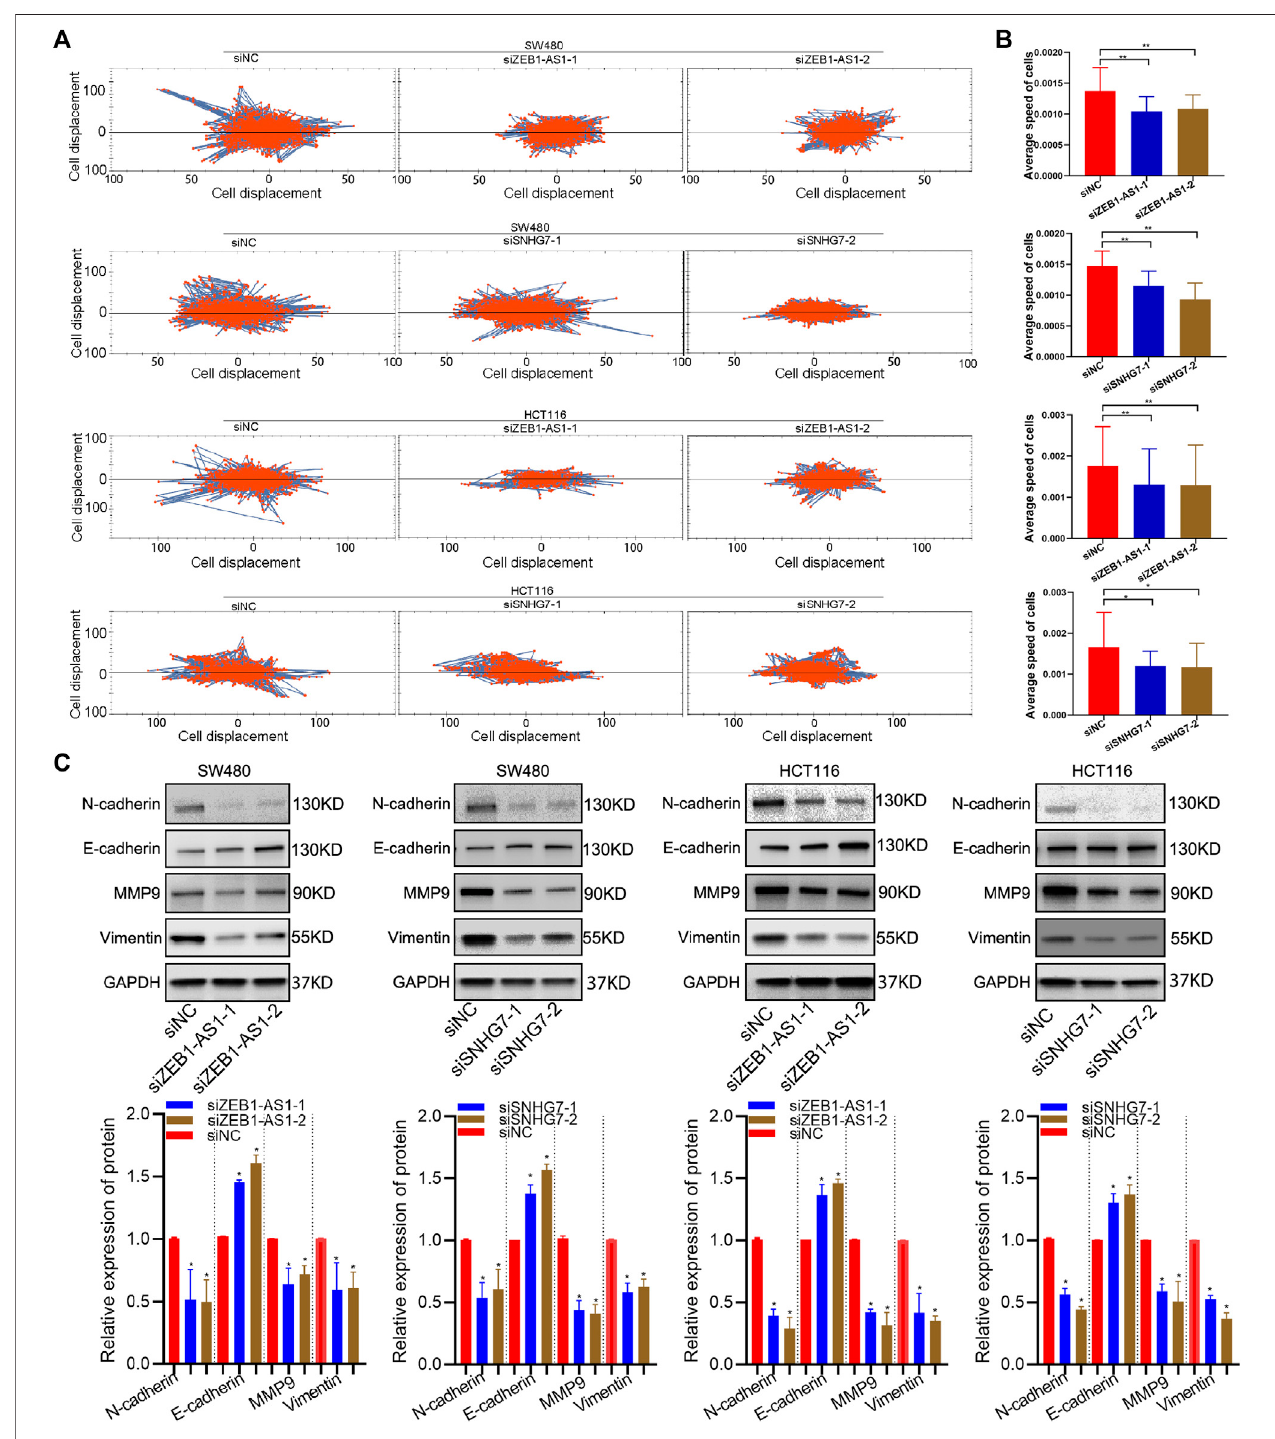
FIGURE12| ZEB1-AS1andSNHG7silencinginhibitedtheEMTphenotype. (A) TheHigh-ThroughputConnotationofImagingSystemwasappliedtocontinuously view the migration of cells, which suggested that ZEB1-AS1 and SNHG7-knockdown cells exhibited a lower cumulative displacement than control cells. (B) The transfected cells moved signi fi cantly slower on average than did the control cells. (C) ZEB1-AS1 and SNHG7 depletion increased the protein level of E-cadherin and decreased the expression of vimentin, N-cadherin, and MMP9.